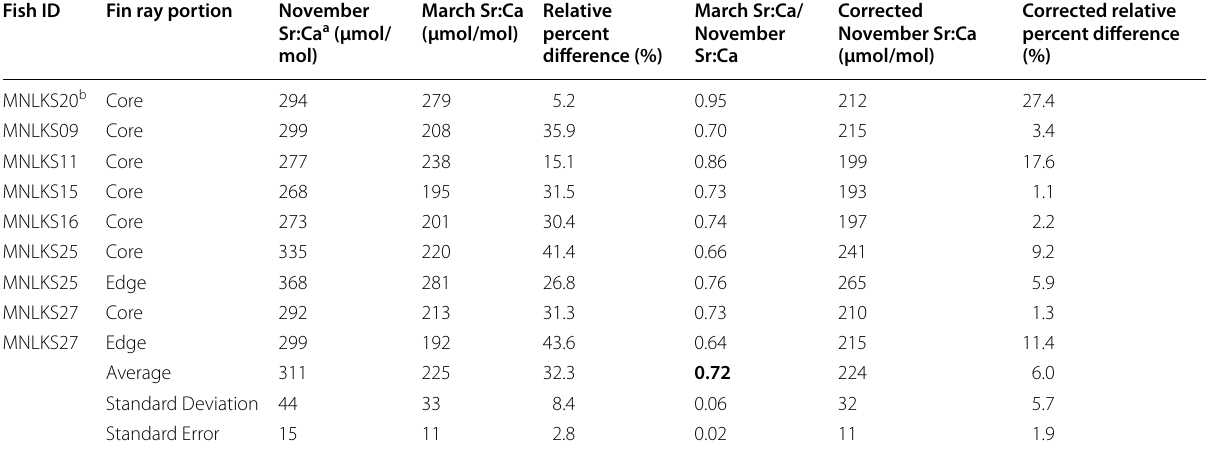
Table 2 Comparisons of sturgeon fin ray laser ablation data collected in November 2015 and March 2016